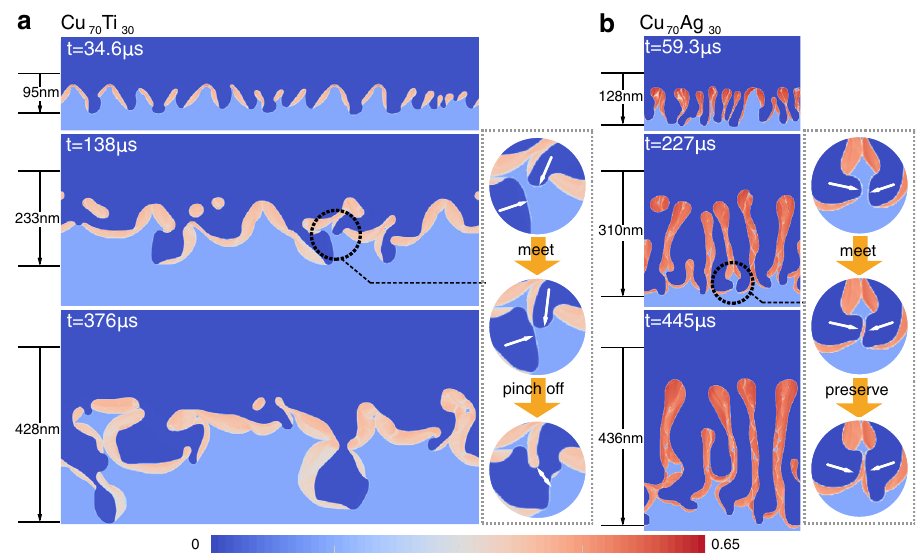
Fig. 2 Interface dynamics controlling topology selection. Snapshots of 2D phase- fi eld simulations of dealloying of Ta 15 Ti 85 alloys by Cu 70 Ti 30 ( a ) and Cu 70 Ag 30 ( b ) melts illustrating unstable diffusion-coupled growth. Snapshots are shown at different dealloying depths measured from the initial position of the planar solid-liquid interface. The insets illustrate different modes of collisions of liquid channels giving rise to solid ligament pinch off and preservation for Cu 70 Ti 30 and Cu 70 Ag 30 melts, respectively. The domain width of Cu 70 Ti 30 is 1024 nm and Cu 70 Ag 30 is 384 nm. The color bar refers to the Ta concentration and different colors distinguish the liquid region (dark blue), base alloy (light blue), and dealloyed structure (near red). Movies of those simulations highlighting the convoluted paths of penetrating liquid channels during unstable diffusion-coupled growth are given in the Supplementary Movies 2 and